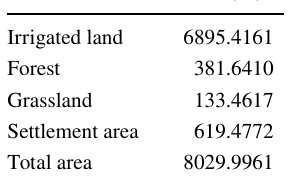
Table 2 Potentials of the three perennial